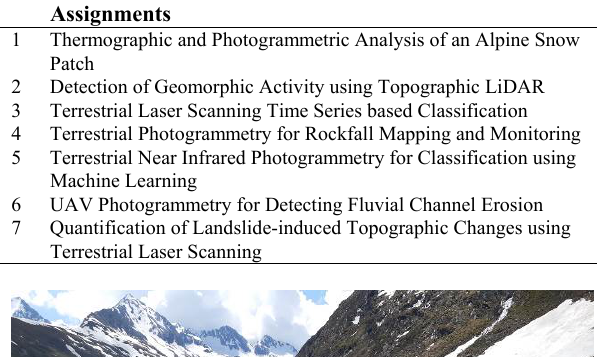
Finally, conducting